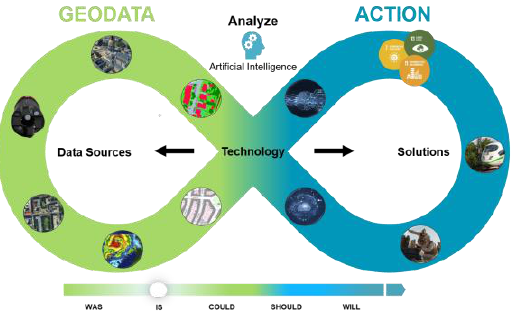
Figure 15: The infinite loop of data, analysis, and action for a (urban) digital